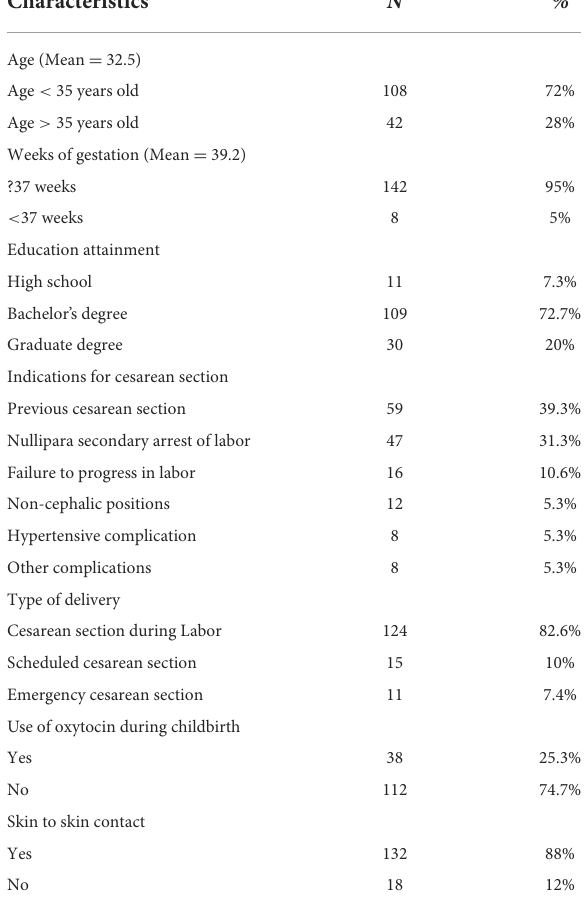
TABLE 1 Sample characteristics ( N =